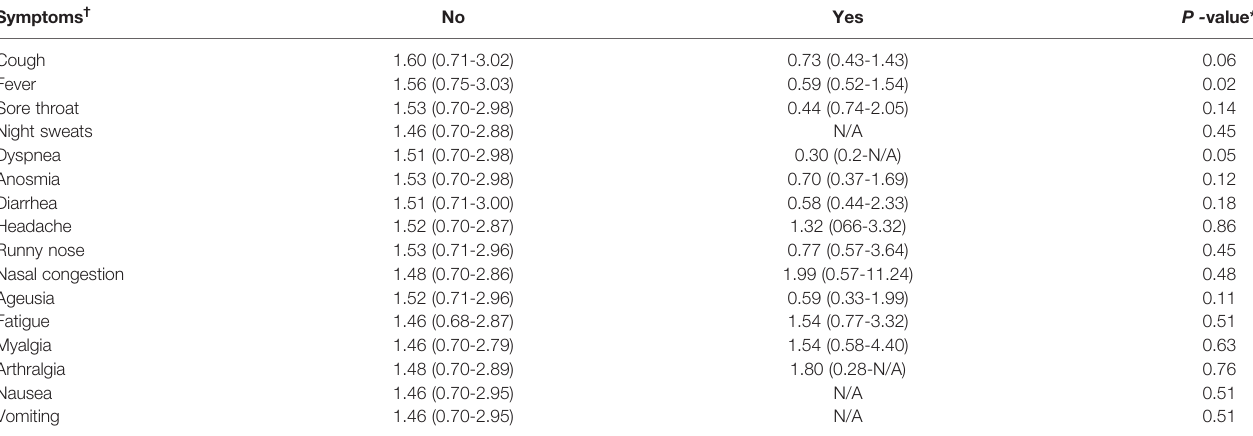
TABLE 8 | Fold of increase of NK IFN- g + cells after M. bovis CFP stimulation according to the different symptoms. Symptoms † No